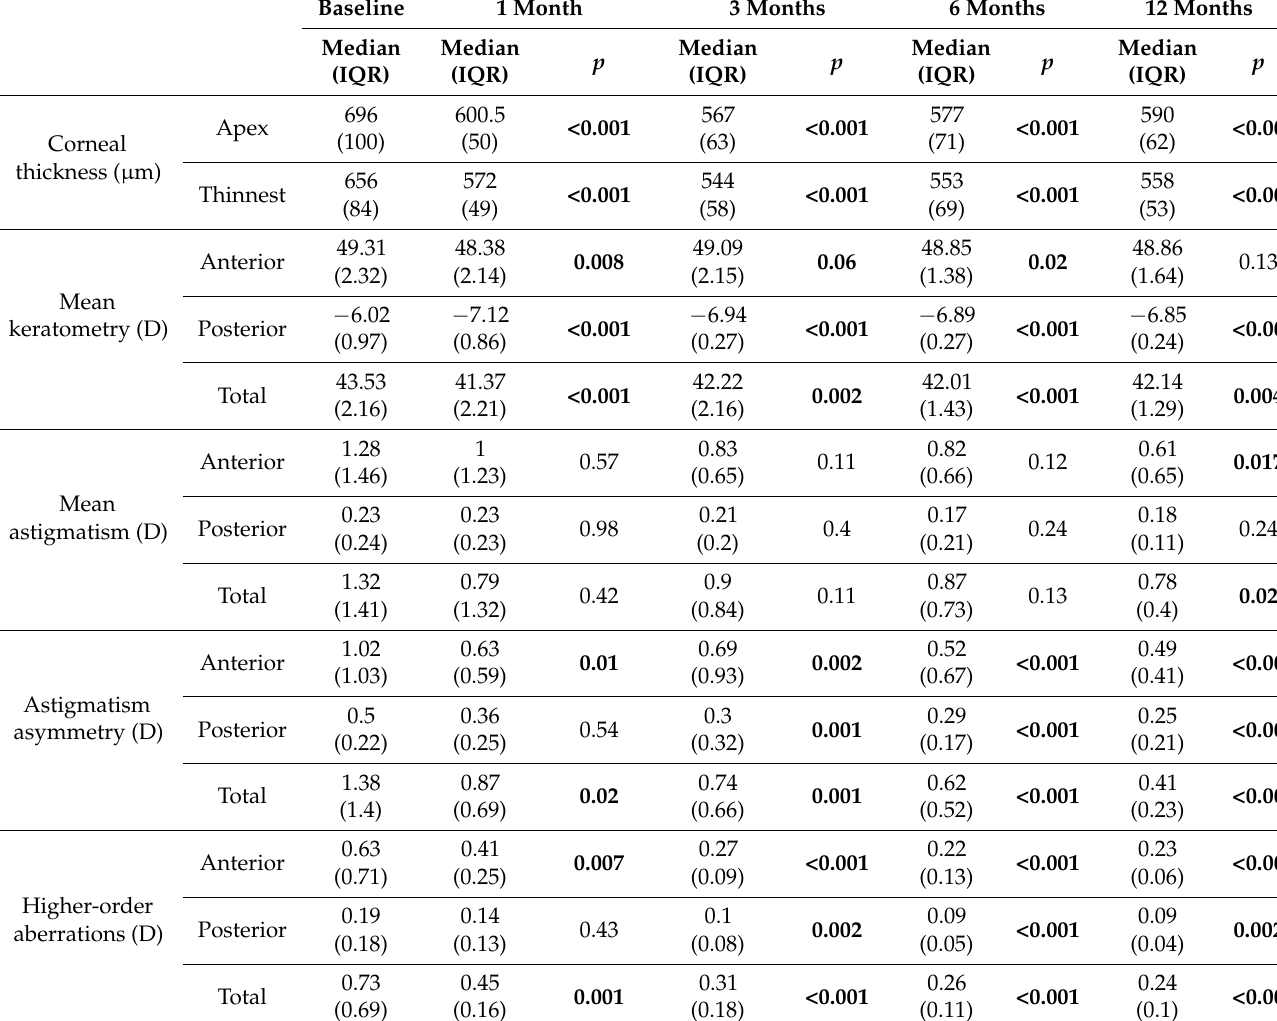
Table 3. Changes in the central corneal thickness (CCT), mean keratometry, astigmatism magnitude, astigmatism asymmetry and higher-order aberration power compared to the baseline in the 3 mm corneal optical zone after ultrathin Descemet stripping automated endothelial keratoplasty (UT-DSAEK). Statistically significant values are shown in